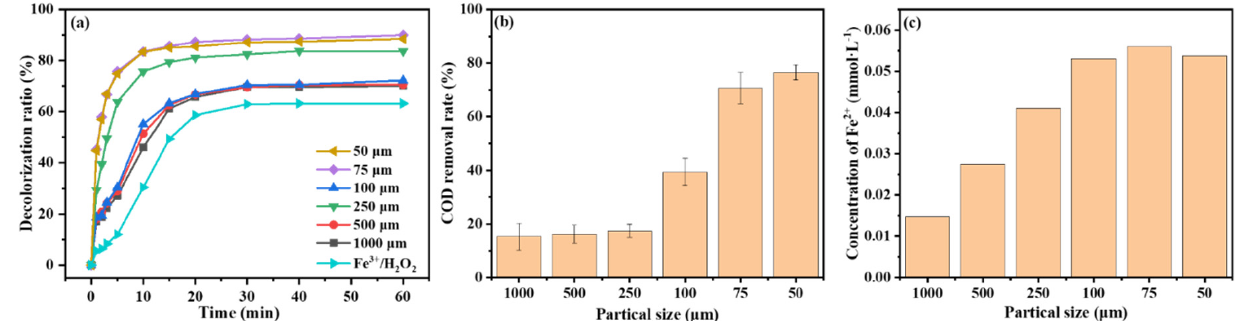
Figure 3. Effect of different CSPAC particle sizes on the ( a ) decolorization rate of ARG, ( b ) COD removal rate in the Fe 3+ /H 2 O 2 /CSPAC system (0.1 mmol/L FeCl 3 , 0.2 mmol/L H 2 O 2 , 100 mg/L ARG, 0.4 g/L CSPAC (50–1000 μ m), pH = 3), and ( c ) generation of Fe 2+ in the Fe 3+ /CSPAC system (0.1 mmol/L FeCl 3 , 0.4 g/L CSPAC (50–1000 μ m), pH = 3).